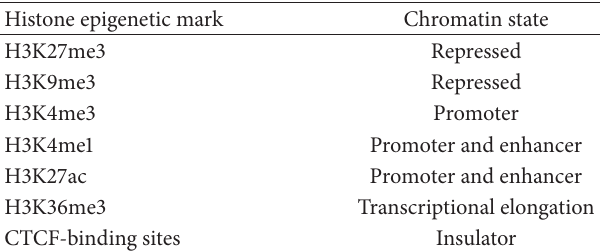
Table 1: Comprehensive summary of histone epigenetic marks and corresponding functional states of the